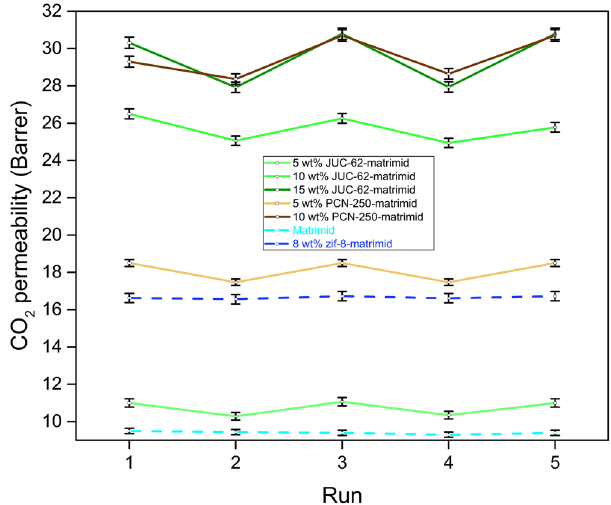
Figure 5. CO 2 permeability light-responsive test.